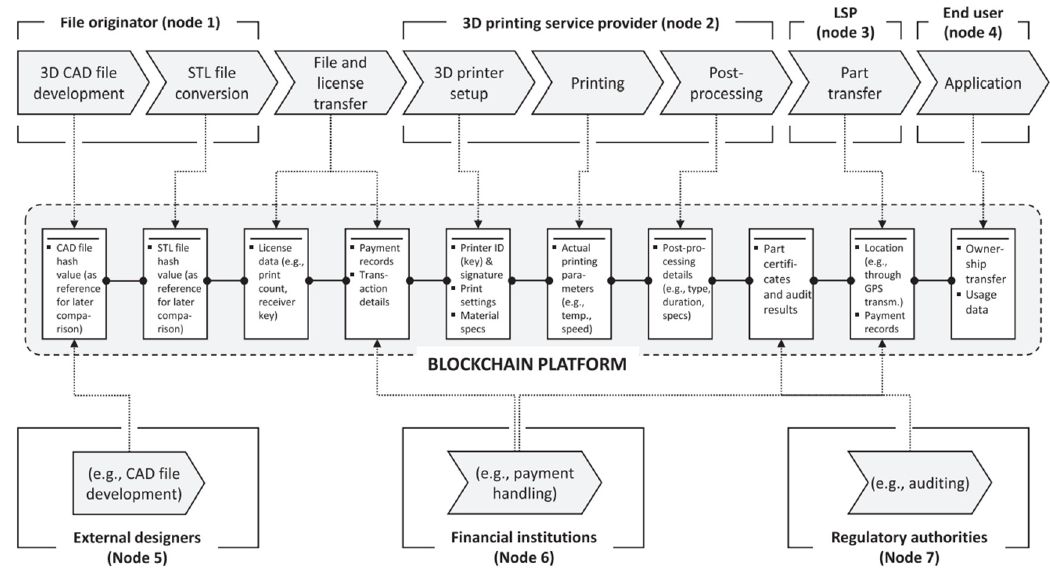
Figure 1. Blockchain platform for 3D printing value chain [14].